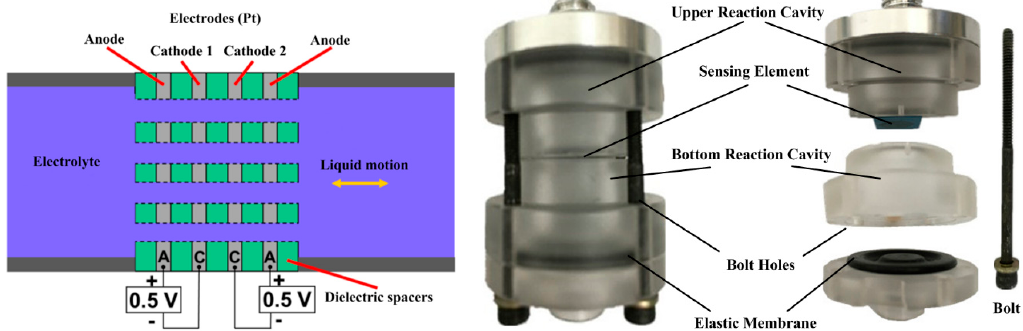
Figure 1. Schematics of the MET ( left ), real product graph and decomposing graph ( right ) structures.